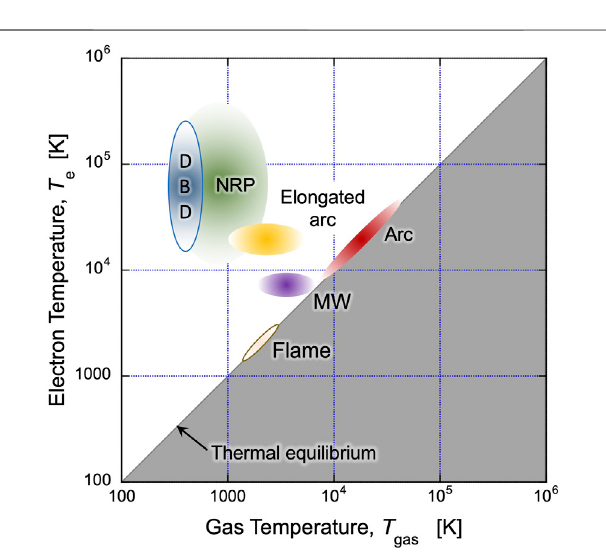
FIGURE 2 | Plasma characteristics in terms of electron temperature ( T e ) and gas temperature ( T gas ) for the selected discharges at atmospheric